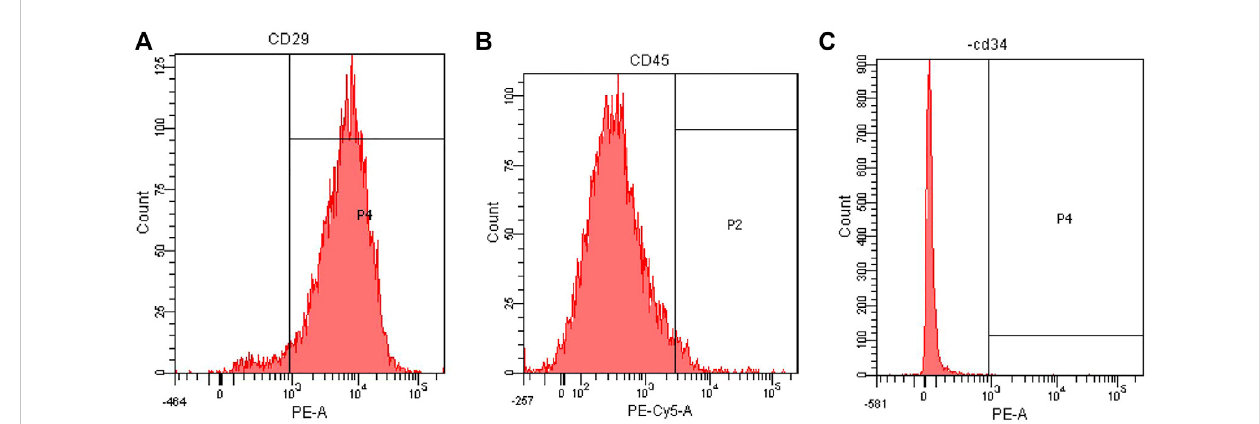
FIGURE 6 Flow cytometry analysis of rat BMSCs. (A) Expression of CD29. (B) Expression of CD45. (C) Expression of CD34.